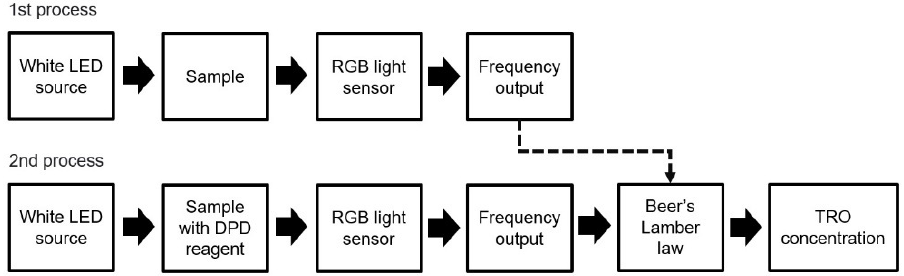
Figure 1. TRO concentration measurement process using DPD colorimetric.